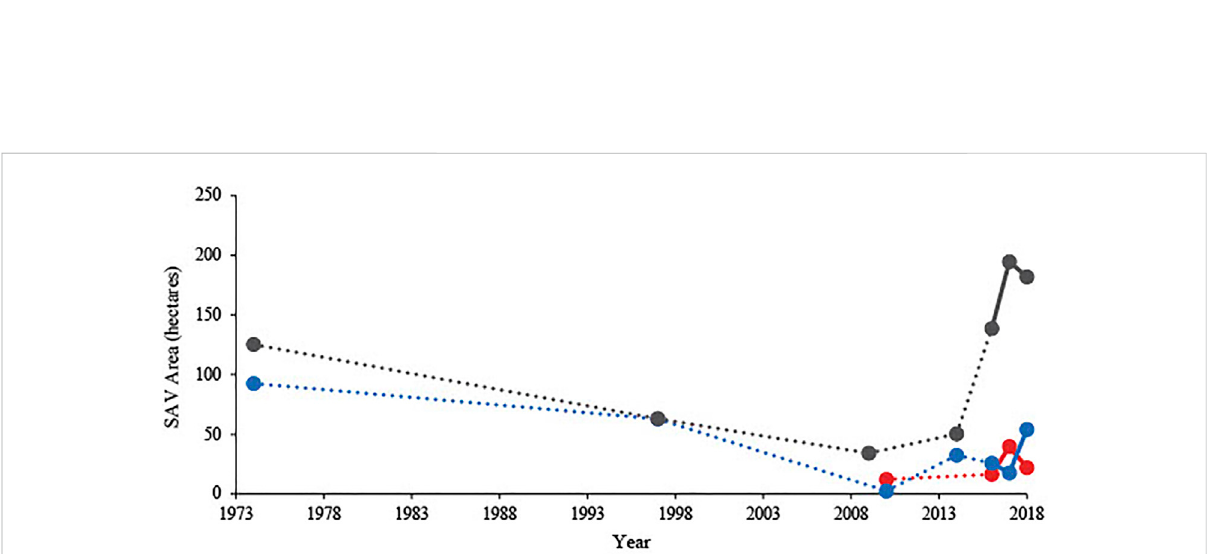
FIGURE 5 Totalarealextent(ha)ofsubmersedaquaticvegetation(SAV)inSAVmappingtransects1 – 4inthewest(red),7 – 13intheeast1(blue),and14 – 17 in the east 2 (grey) carp-exclusion zones, 1974, 1997, 2009, 2010, 2014, and 2016 – 2018, Delta Marsh, Manitoba. Dotted lines connect non- consecutive survey years; solid lines connect consecutive survey